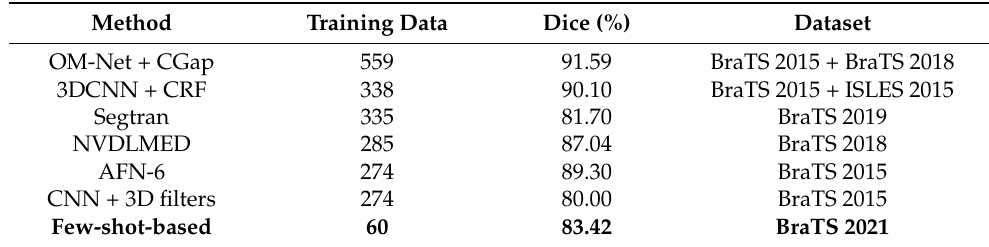
Table 2. Comparative table showing dice scores (in percentage) of different deep learning methods with the amount of training data (number of MRI scans) used along with dataset names.